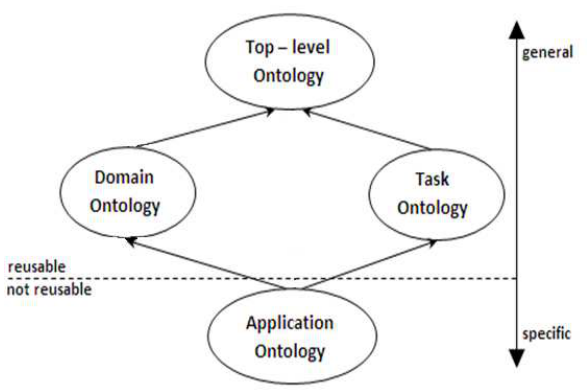
Figure 1. Classification of ontologies based on their level of abstraction. Adopted from (Guarino, 1998) Top-level ontologies capture general concepts useful across several domains. The main role of this ontology type is to bring interoperability between several domain ontologies, for